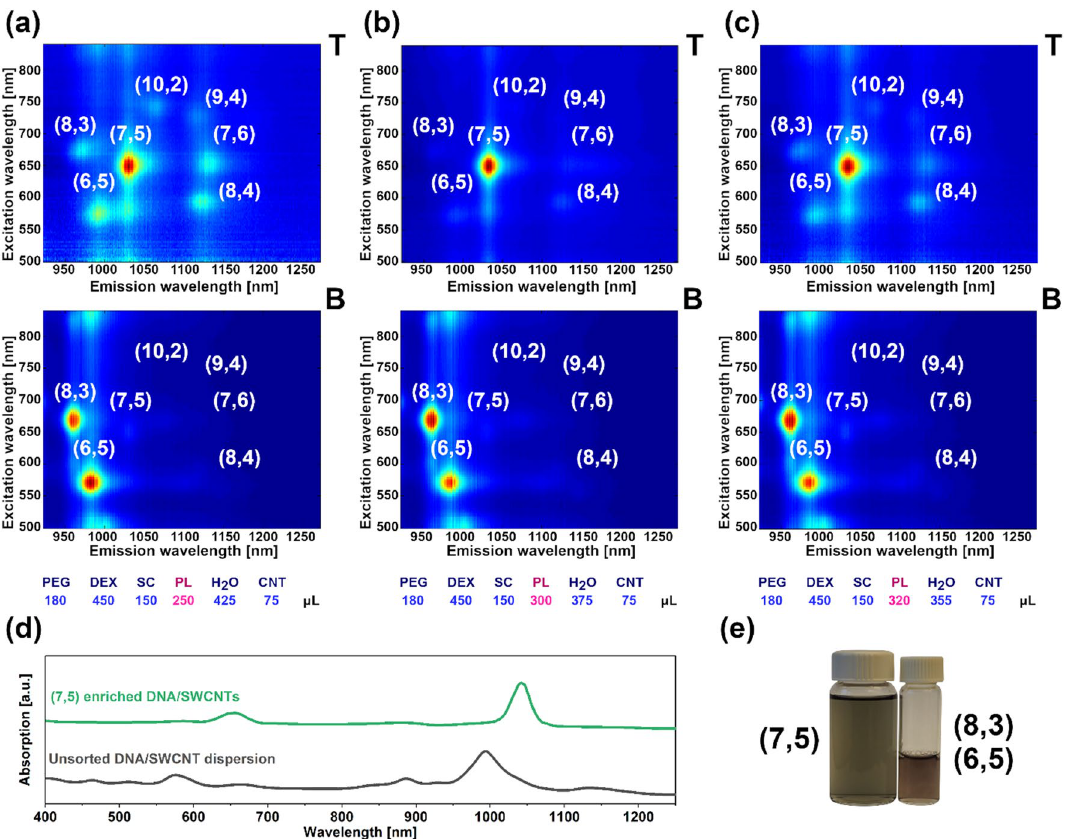
Figure 7. Isolation of DNA-dispersed SWCNTs. 2D PLE maps of DNA-dispersed, (6,5)-enriched SWCNTs sorted by ATPE upon varying the volume of Pluronic to ( a ) 250 µL, ( b ) 300 µL and ( c ) 320 µL. ( d ) Absorption spectra of (7,5) rich SWCNT phase and the parent dispersion, ( e ) vials with isolated chirality-enriched SWCNT dispersions (both from the samples obtained at the content of Pluronic equal to 300